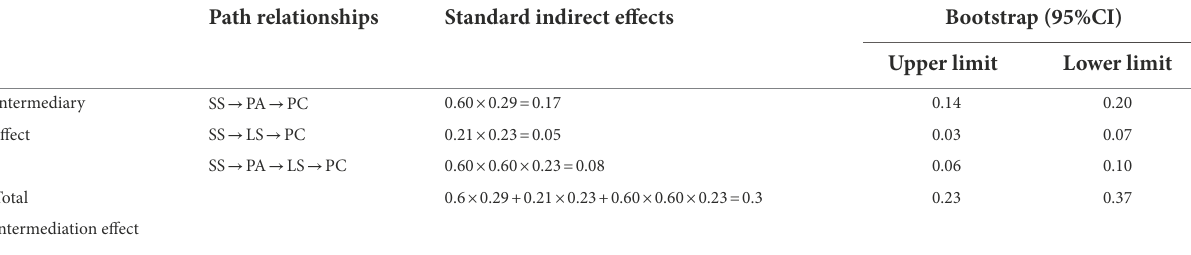
TABLE 3 Bootstrap analysis of the significance test of the intermediate model effect. Path